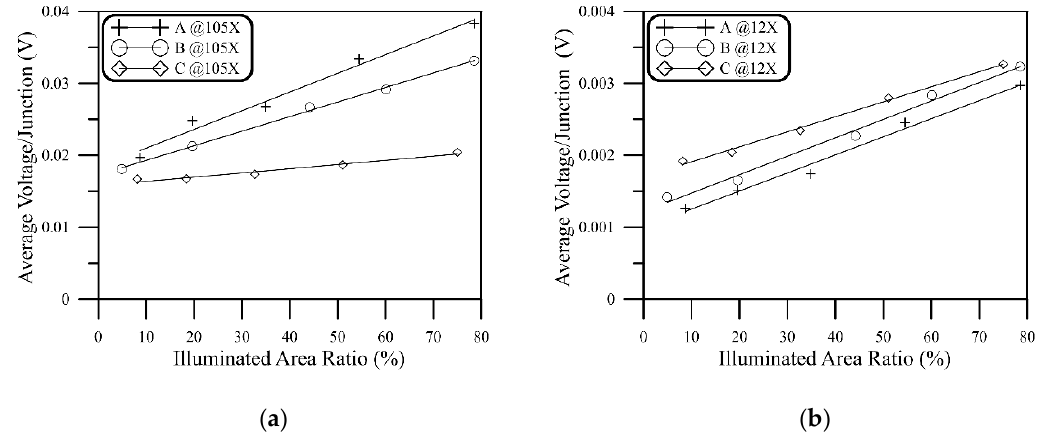
Figure 4. Increase in average voltage per number of junctions of the three samples, A (3-cm TEG), B (4-cm TEG), and C (6.2-cm TEG), with increasing the percentage of illumination covering of the TEG surfaces at ( a ) 105 × and ( b ) 12 × .